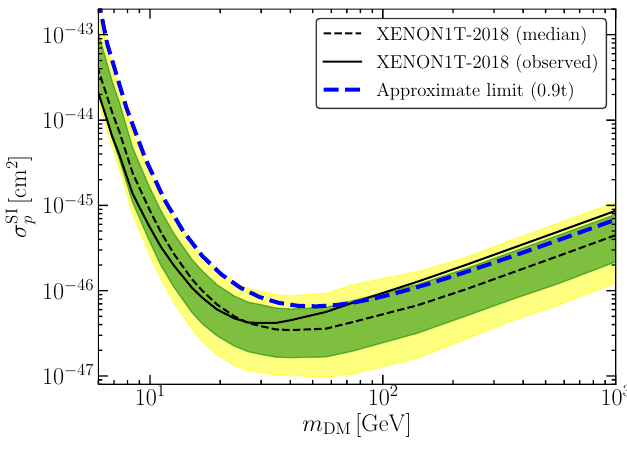
Figure 10 . Approximate XENON1T bound (dashed blue) calculated from a single-bin Poisson upper limit. We show for comparison the median expected sensitivity (dashed black) and observed limit (solid black) of the XENON1T 2018 exposure [40]. Shaded bands show the 1 (cid:27) and 2 (cid:27) bands on the sensitivity. Our limit matches the o(cid:14)cial limit within a factor of a few for all DM masses above 10